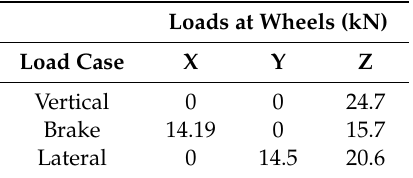
Table 2. Load cases applied in MSC /